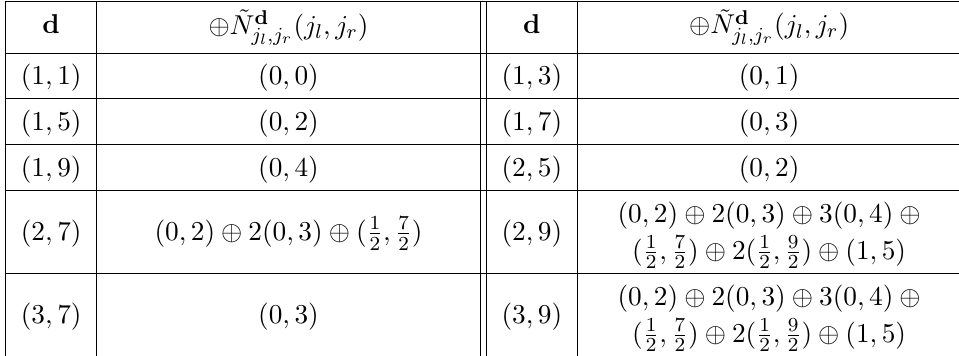
Table 1 . Spectrum of BPS bound states to a fundamental Wilson loop in the SU(2) 0 theory for d 1 ≤ 3 and d 2 ≤ 10 . Here, d = ( d 1 , d 2 ) labels the bound states with charge d 1 m + d 2 φ